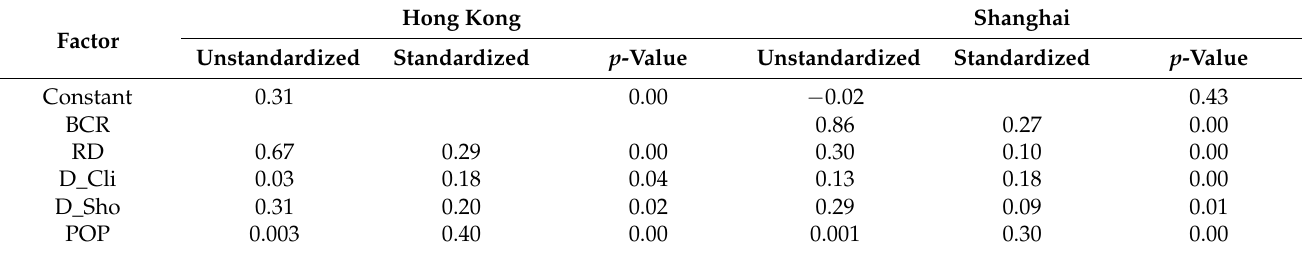
Table 3. Stepwise regression results (e.g., regression coefficients and p values) for Hong Kong and